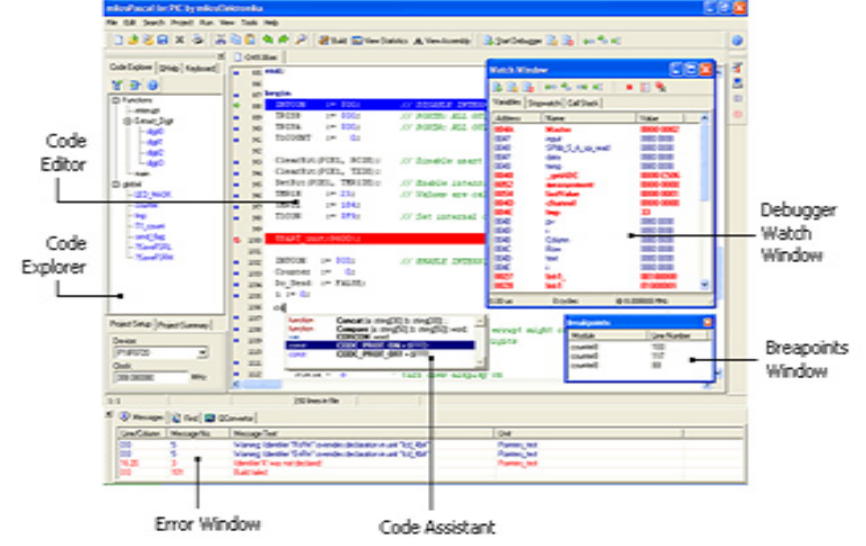
Fig. 4. Screenshot of the software MikroBasic [8] .